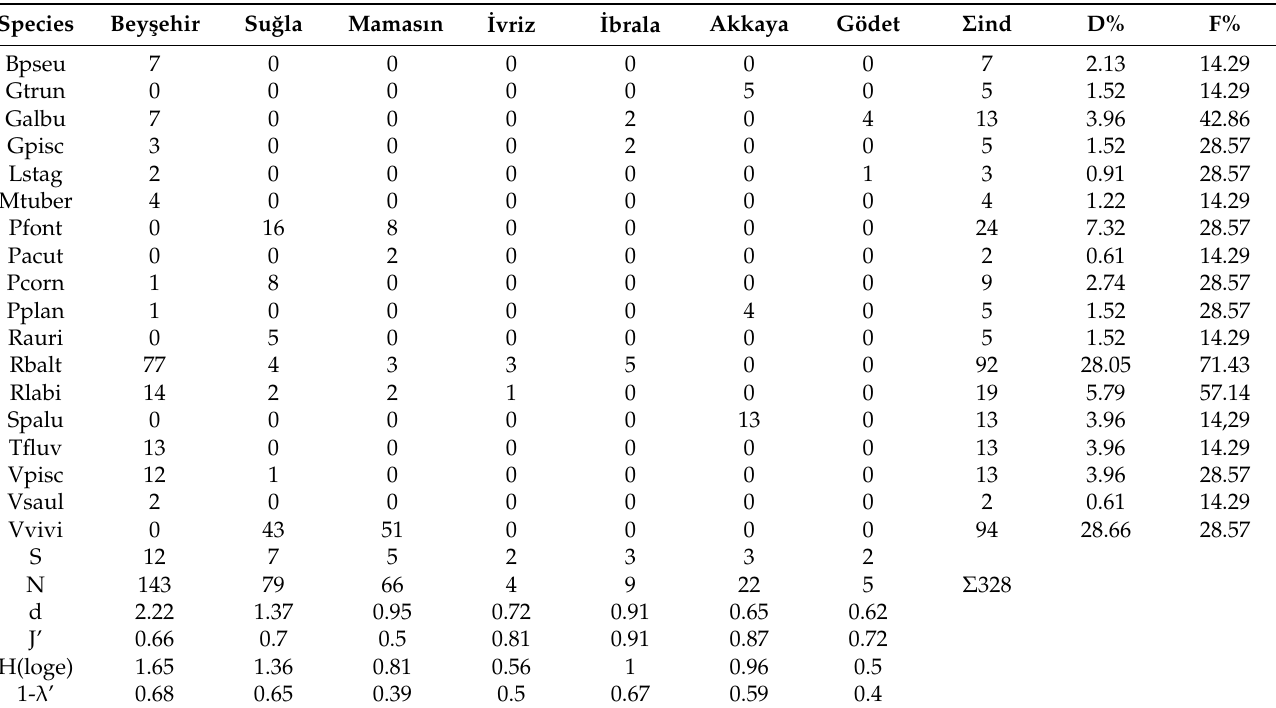
Table 5. Species list, number of identified specimen (individual m − 2 ).